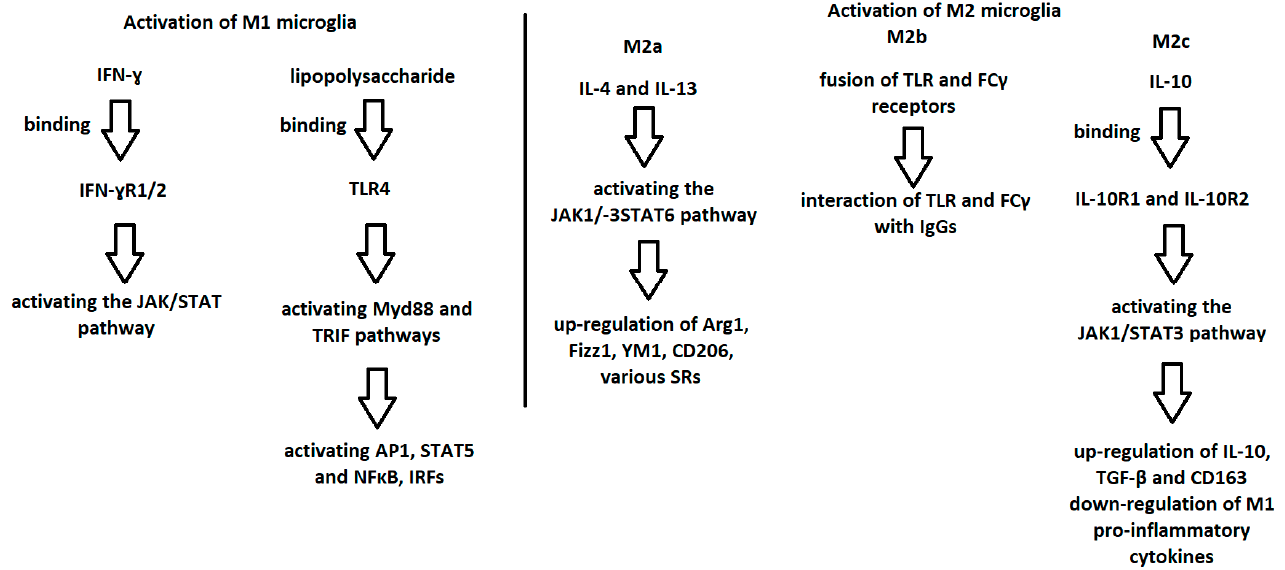
Figure 1. Graphic demonstration of the mechanism of microglia activation to the M1 and M2 phenotypes.